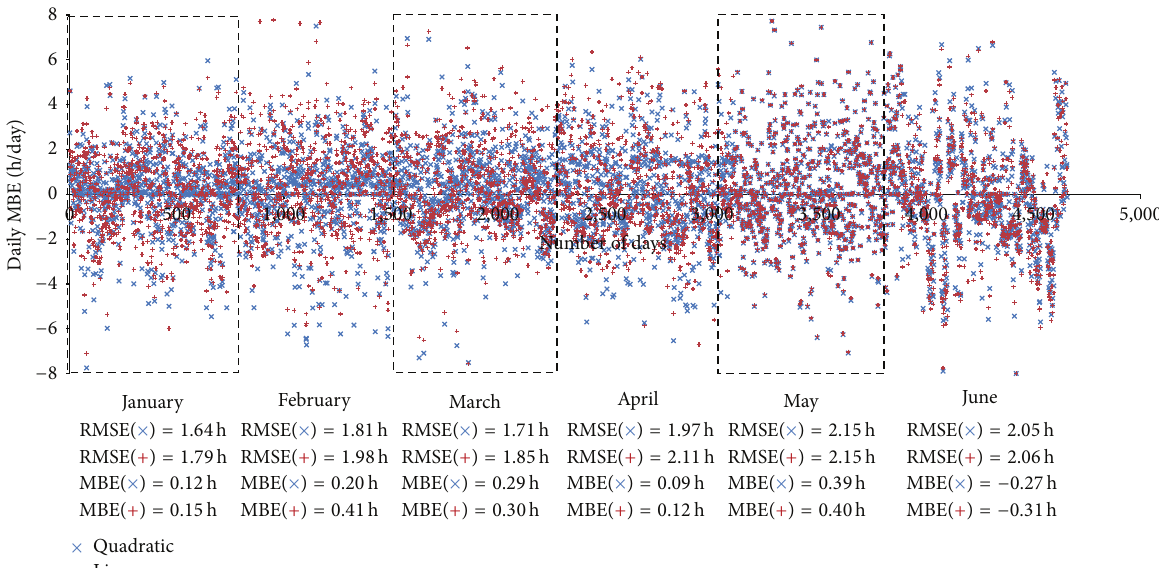
Figure 3: Daily MBE values of quadratic and linear models for six months for all